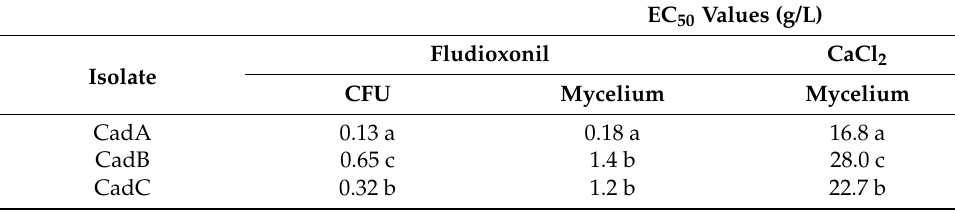
Table 2. EC 50 values of fludioxonil and CaCl 2 tested on Cadophora luteo-olivacea isolates colony growth and CFU. EC 50 values were calculated using the probit analysis applied to the percentage of inhibition of CFU and mycelial diameter growth, detected after 15 days of incubation at 20 ◦ C. Different letters indicate significant differences among fungal isolates, according to Tukey’s HSD Test ( α = 0.05). EC 50 Values (g/L) Fludioxonil CaCl 2 Isolate CFU Mycelium